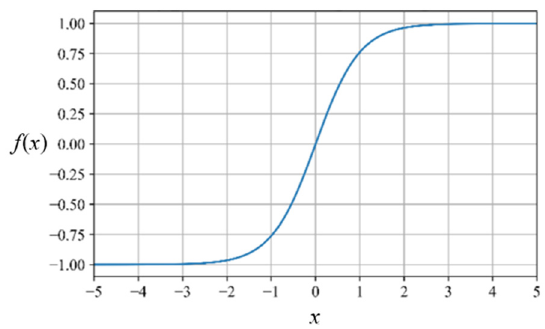
Figure 12. The hyperbolic tangent function.